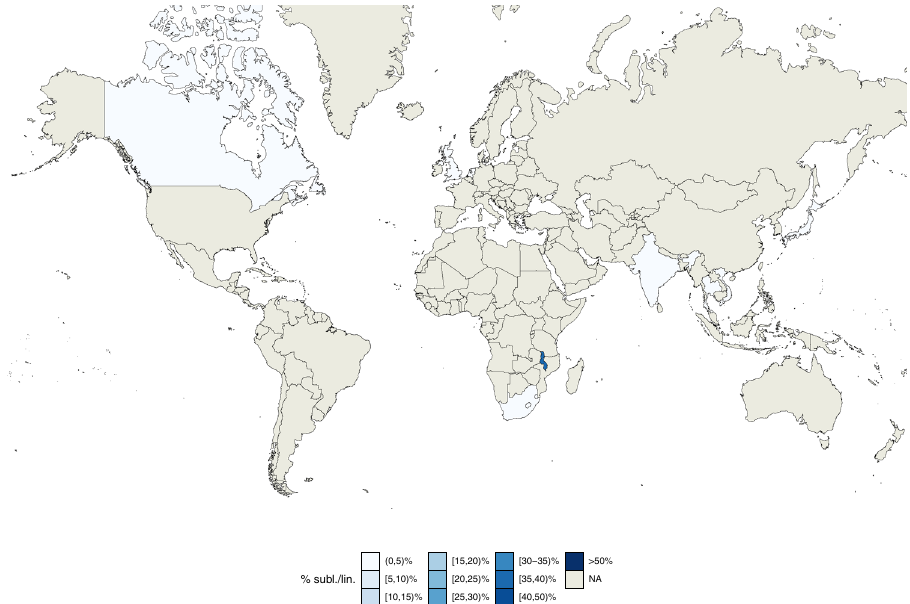
Fig. 6 Geographic distribution of internal sub-lineage 1.1.3.i1. Colors represent the percentage of 1.1.3.i1 strains isolated in a given country with respect to all lineage 1 strains isolated in such country. Source data are provided as a Source Data fi le.